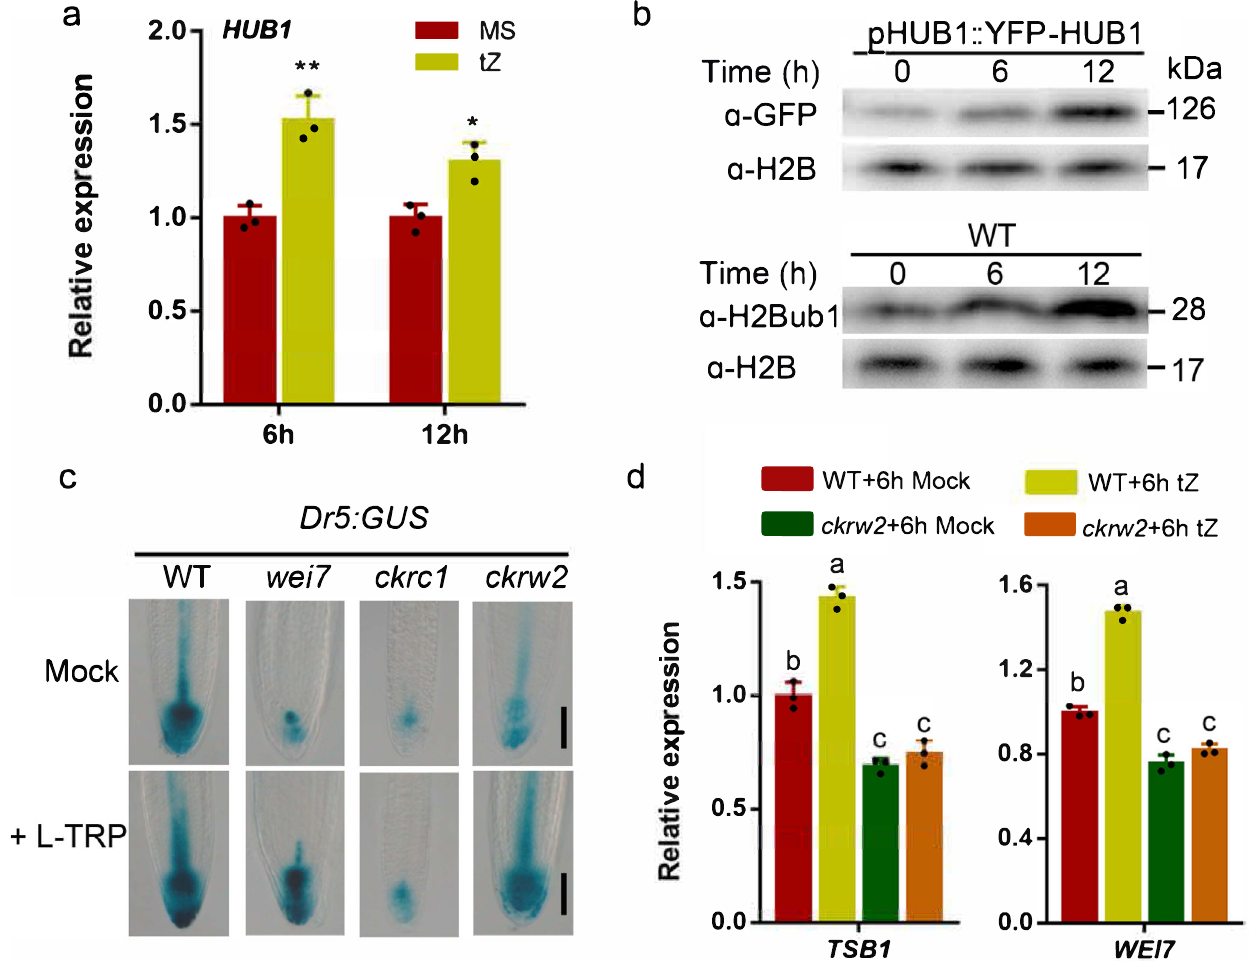
Fig. 4 Evidences supporting the role of HUB1/2-mediated H2Bub1 in mediating regulation on auxin biosynthesis by CK in Arabidopsis. a , b Effects